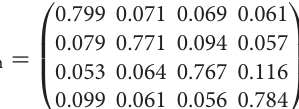
distribution ( p i ) and the null distribution ( q i ) is measured by